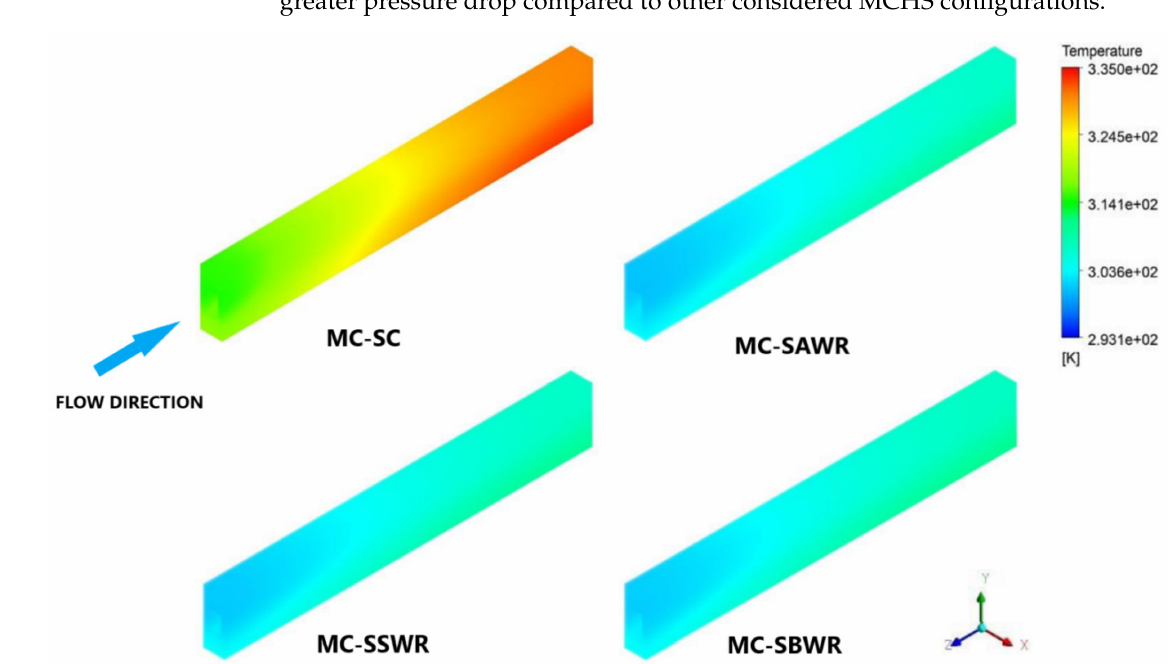
Figure 16. Temperature distribution for various MCHS configurations at Re = 500.